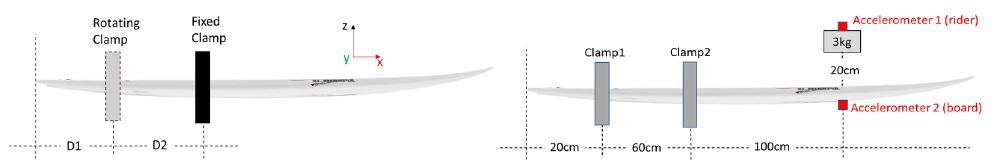
Figure 2. Setup for drop weight test ( left ) and torsional stiffness test via flex machine ( right ). D1 and D2 indicate the distance from the tail of the board and the distance over which the surfboard is twisted,